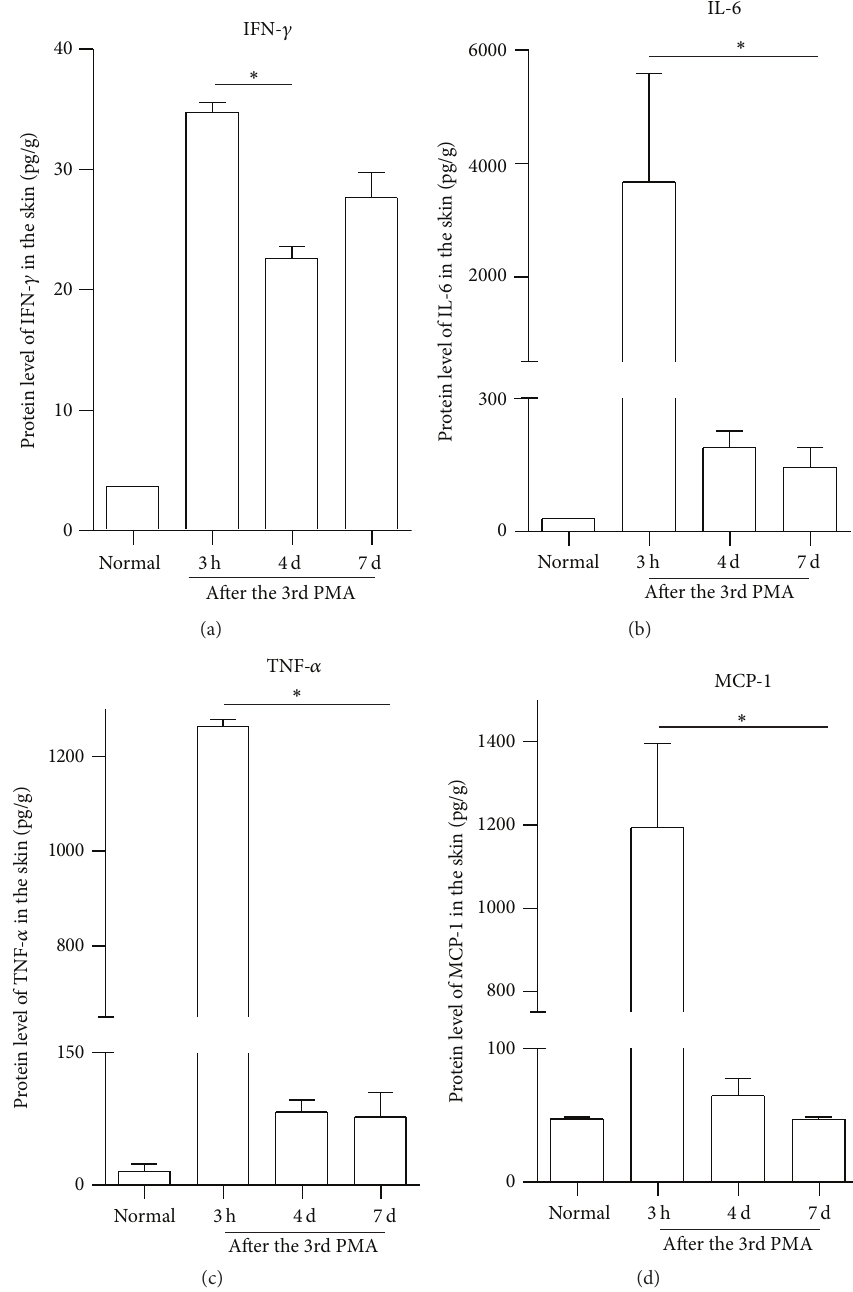
Figure 1: IFN- 𝛾 expression in the skin maintained at a relatively high level during the resolution stage of PMA-induced inflammation. PMA was painted to the dorsal skin of mice ( 𝑛 = 3 per group) for 3 times (twice a week) and then stopped for the resolution of inflammation. Mice were sacrificed 3 hours, 4 days, or 7 days after the third PMA treatment. The skins were removed, weighted, and homogenized in ice- cold Tris-EDTA buffer. The concentrations of IFN- 𝛾 (a), IL-6 (b), TNF- 𝛼 (c), or MCP-1 (d) in tissue supernatants were then detected at the indicated times. ∗ 𝑃 < 0.05 , compared to the level of 3 hours after the 3rd PMA treatment.